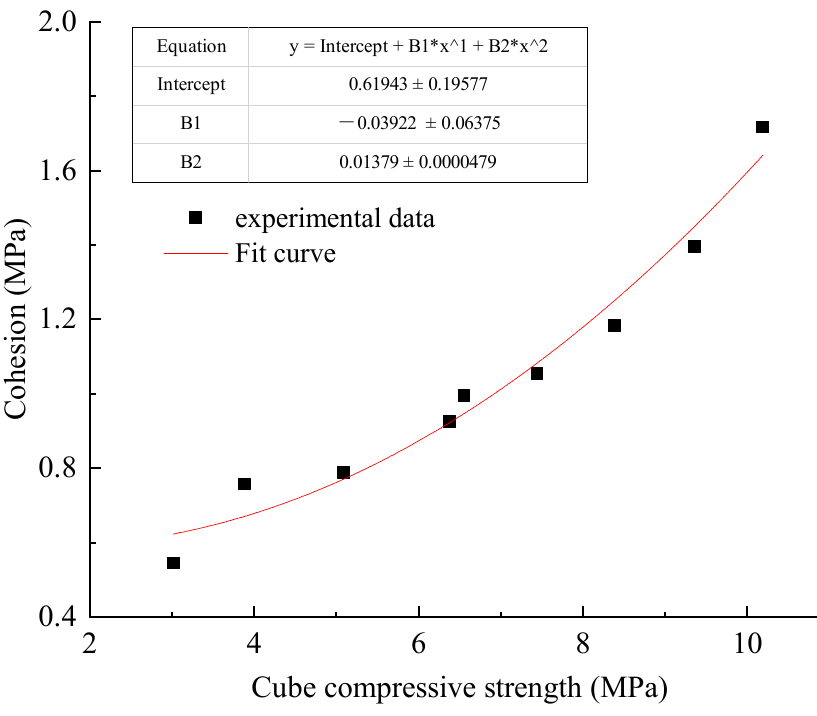
Figure 6. Relationship between cube compressive strength and cohesion.